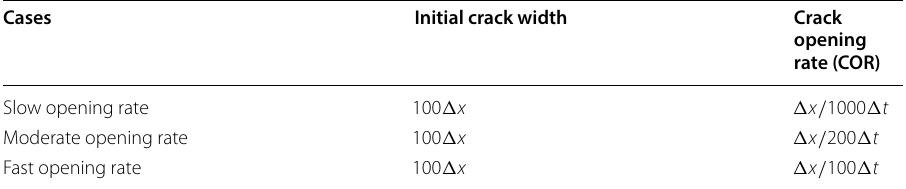
Table 2 Values of the prescribed initial crack width and the crack opening rates for three different